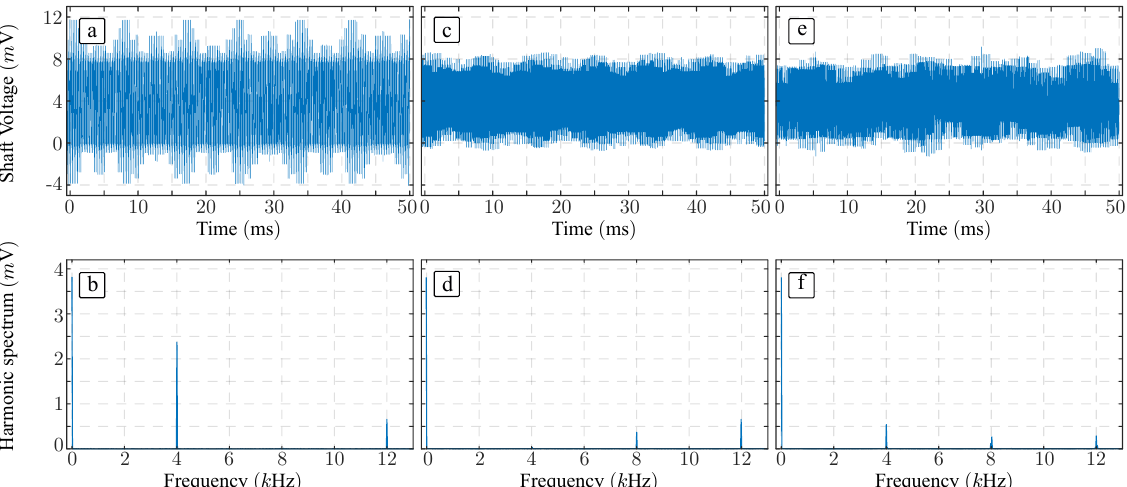
Figure 15. PMSM shaft voltage with rotational speed equal to 25 rpm (corresponding modulation index 0.2) using the PWM method with carrier phase-displacement angles [ φ a , φ b , φ c ] equal to ( a ) [ 0,0,0 ] ◦ ( c ) [ 0,120,240 ] ◦ ( e ) [ 0, φ b their respective harmonic